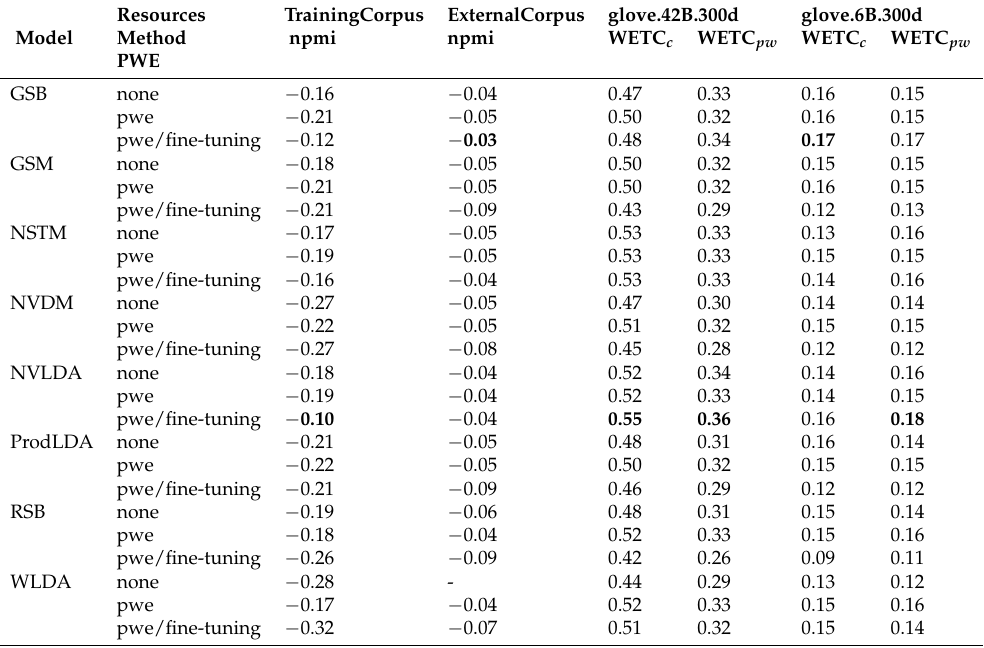
Figure 4. Summary of TC results. Table 3. Topic Coherence on